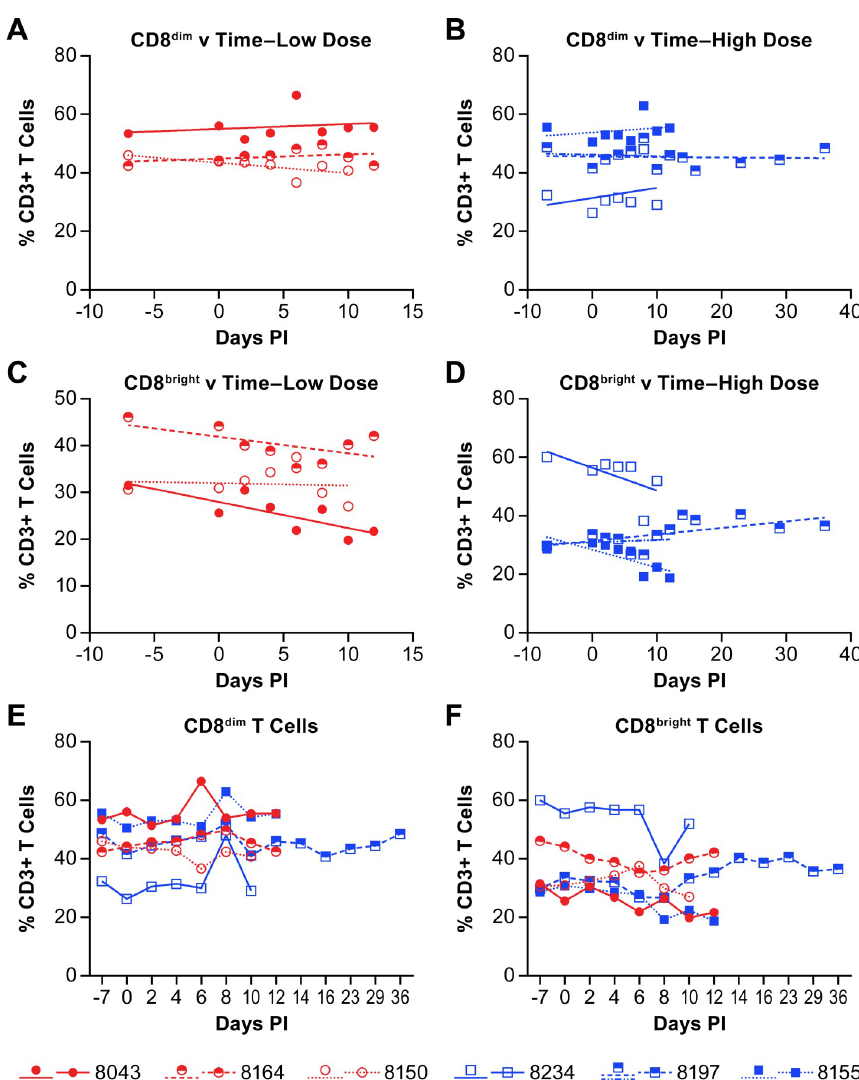
Fig 6. Changes in CD8+ T cell populations in animals infected with NiV. Linear regression analysis of the percent of CD8 dim (A, B) and CD8 bright (C, D) T cells within the CD3+ cell population of individual animals are shown for both the low (A, C) and high (B, D) dose groups over the course of disease. The r-values for the linear regression analyses are provided in S1 Table. Linear regression analysis was performed on samples from all animals through day 12 (acute phase) with additional analysis of the surviving animal over the entire course of disease (blue dashed line). Panels E and F show the populations of CD8 dim and CD8 bright T cells, respectively where red circles indicate the low dose group and blue squares indicate the high dose